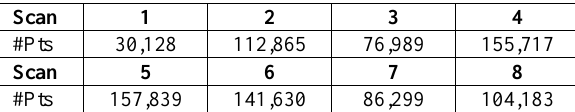
Table 1. Number of points of each scan of Purdue data.